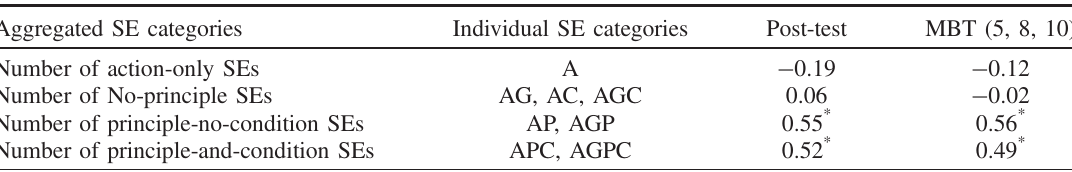
TABLE IV. Correlations between the aggregated self-explanation measures, post-test problem-solving score, and score on MBT items 5, 8, and 10. Note that n ¼ 18 for all